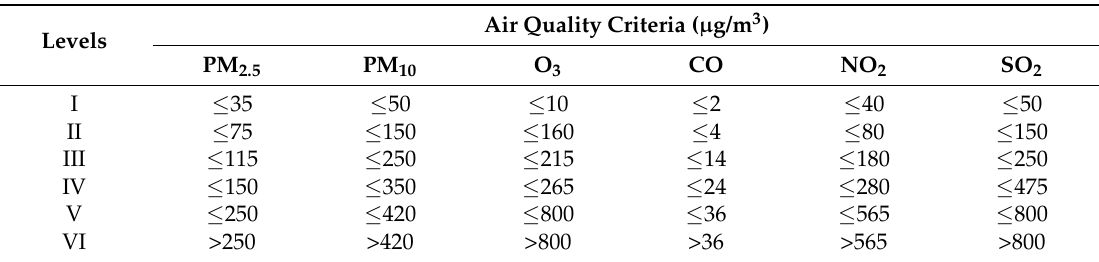
Table 1. Quantitative boundaries of air pollution levels of all